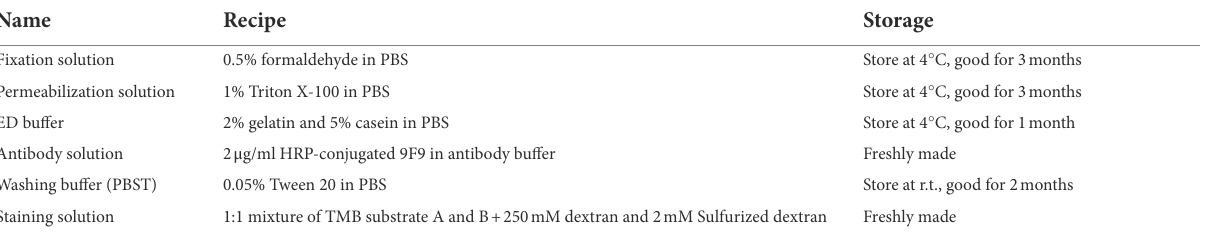
TABLE 2 Compositions and storage conditions of buffers and solutions used in Nt-ELISPOT.